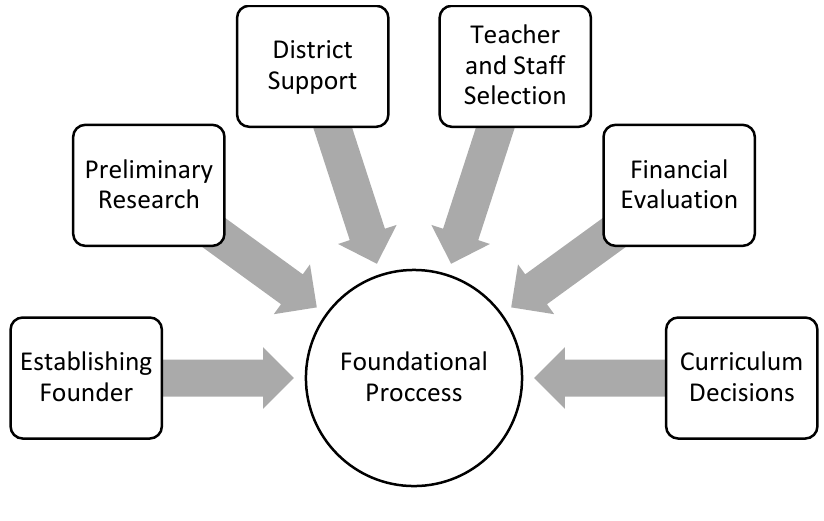
Figure 1. Identified foundational